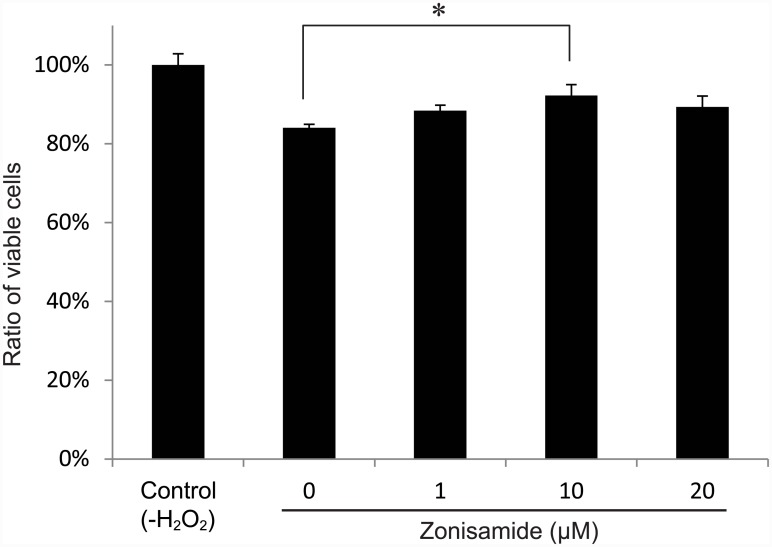
Zonisamide rescues cell death due to oxidative stress.Primary motor neurons in DMEM/F12 with 0.5% FBS were treated with variable concentrations of zonisamide. After 1 h, cells were exposed to 100 μM hydrogen peroxide (H2O2) for 24 h. The number of viable cells was estimated by the MTS assay and was normalized to that without H2O2 (control). Mean and SE are indicated (n = 6). *p < 0.05 by one-way ANOVA followed by Tukey HSD.